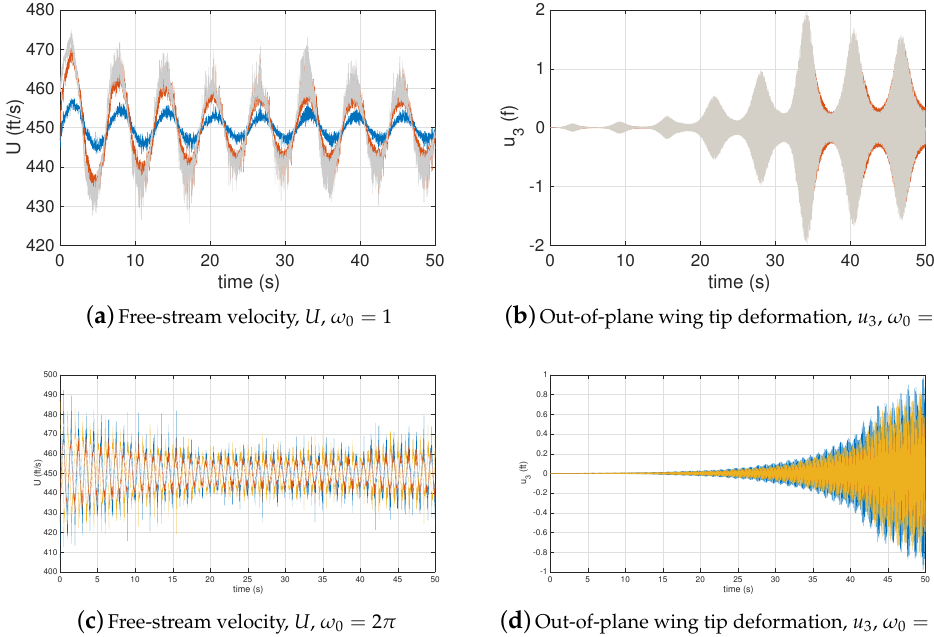
Figure 24. Goland Wing Oscillation with correlation function, r xx = Cos ( ω 0 τ ) , ∆ = 0.1, and U ave = 450